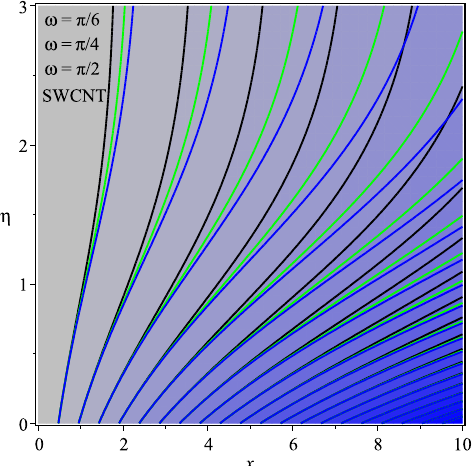
Figure 18. Repercussion of φ with M egt = 0.5, Ω = 1, κ = 2.5, ω = π /3 on stream lines.